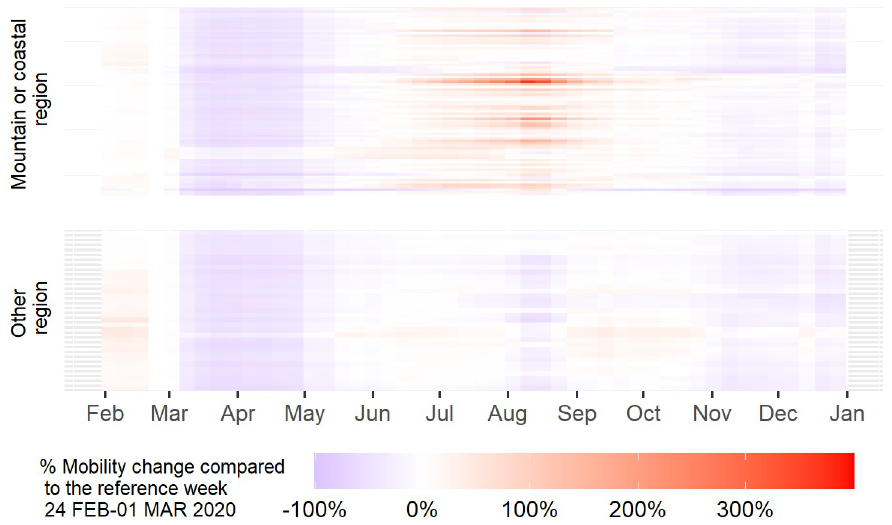
Fig 5. Percentage weekly relative change in the internal mobility of NUTS3 areas in Italy in respect to the pre- COVID-19 mobility levels (week 24 FEB–01 MAR 2020).